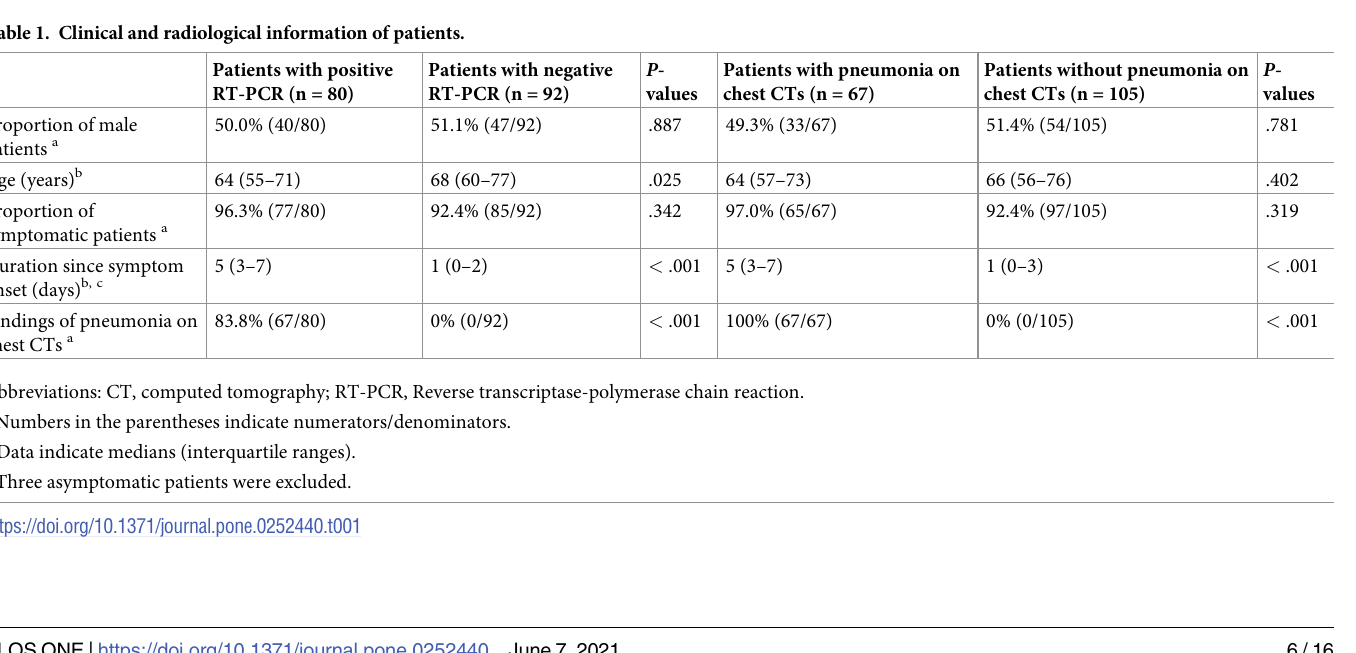
Table 1. Clinical and radiological information of patients.